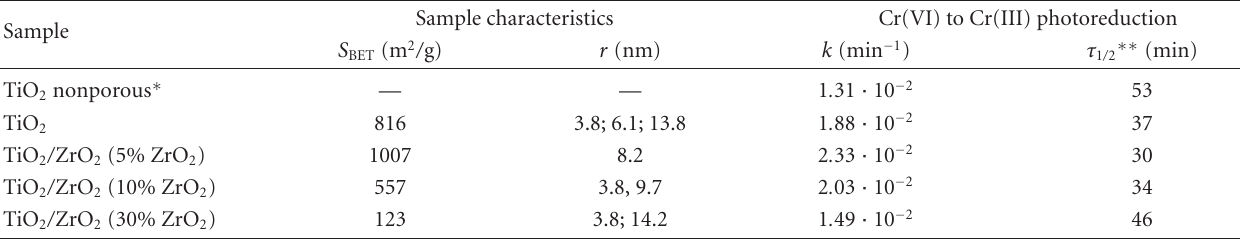
Table 1: Surface characteristics, rate constants, and half-conversion time for Cr(VI) to Cr(III) photoreduction over TiO 2 and TiO 2 / ZrO 2 mesoporous films calcined at 500 ◦ C.